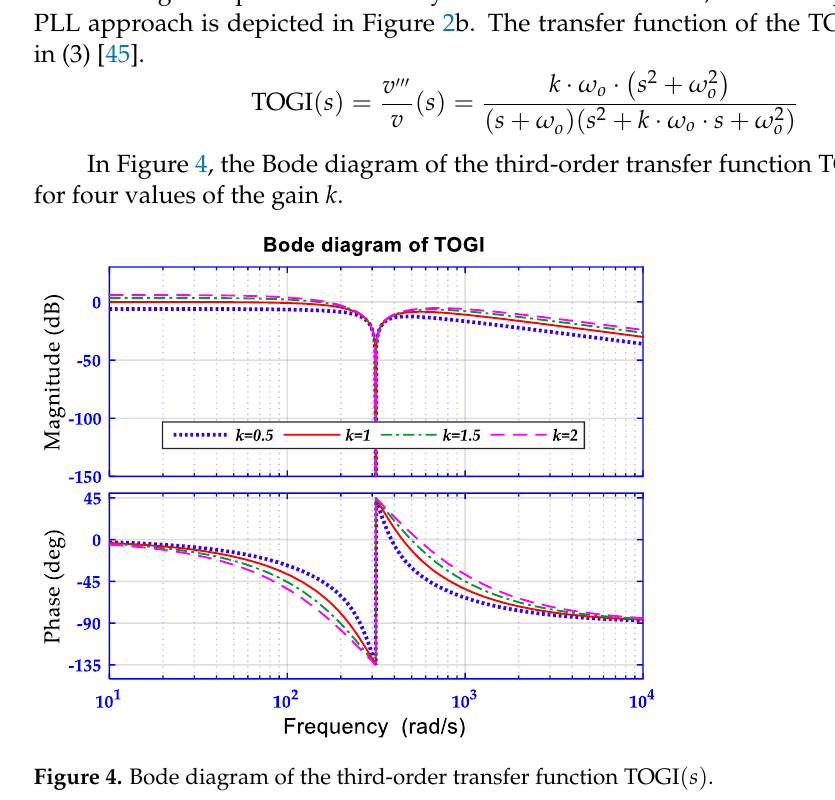
Figure 4. Bode diagram of the third-order transfer function